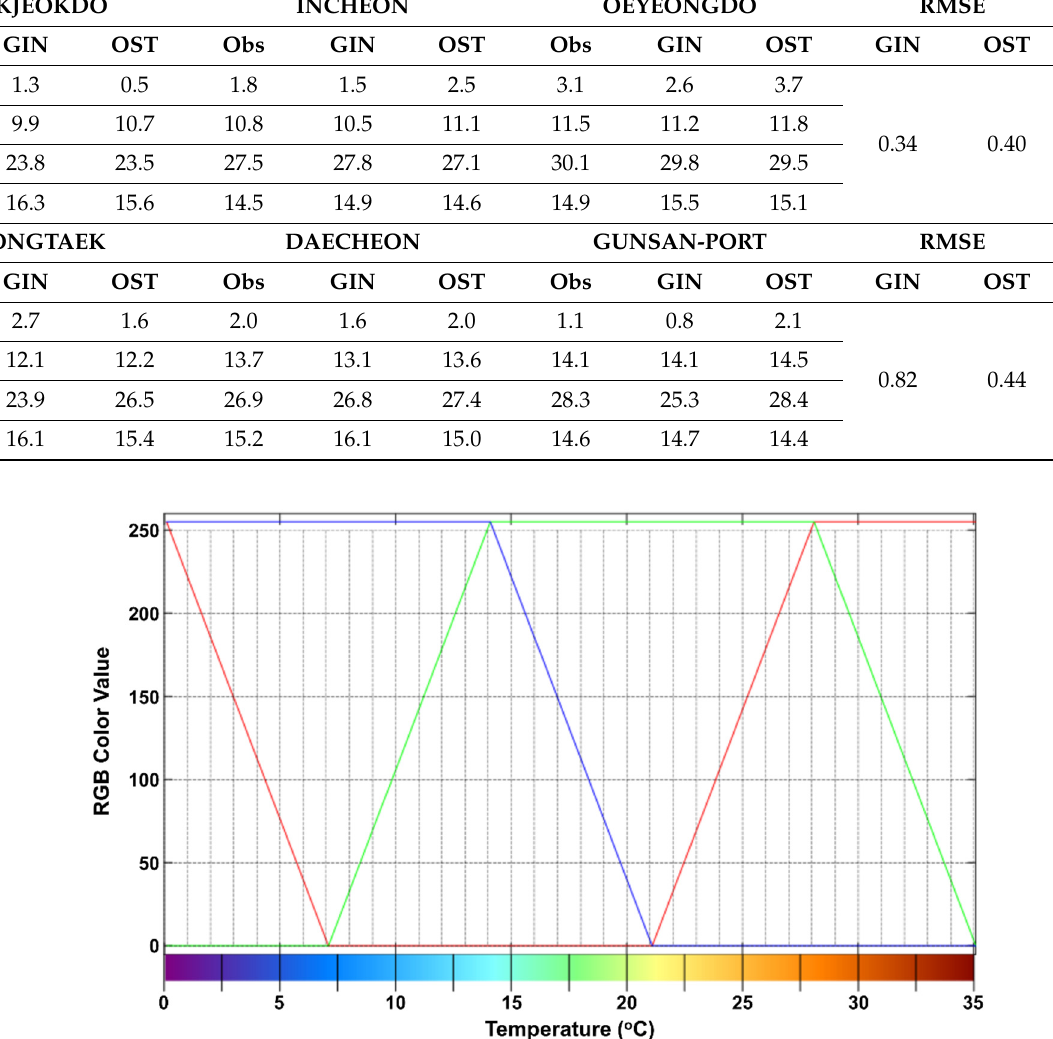
Table 2. Comparison of the GIN and OSTIA with buoy observations.